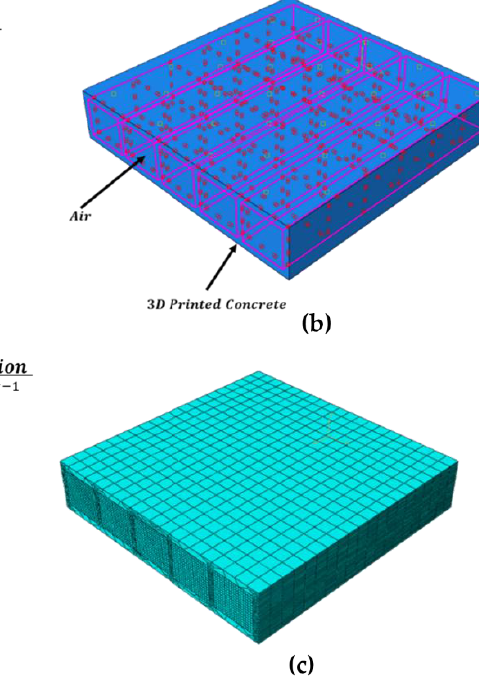
Figure 3. ( a ) Geometry and boundary conditions; ( b ) tie constraints; ( c ) meshing.